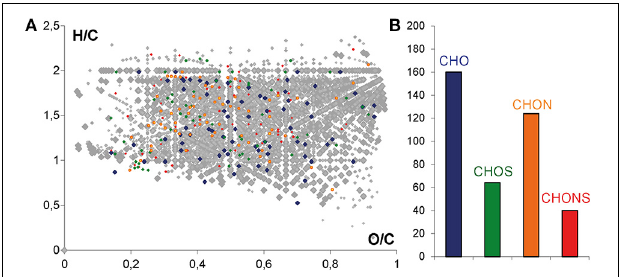
FIGURE 4 | (A) H/C vs. O/C van Krevelen diagram of the masses from FTICR-MS (gray) and common masses from UPLC-QToF-MS and FTICR-MS. (B) Histograms of the relative frequency of common masses from UPLC-QToF-MS and FTICR-MS. Color code: CHO, blue; CHOS, green; CHON, red; CHONS, orange.